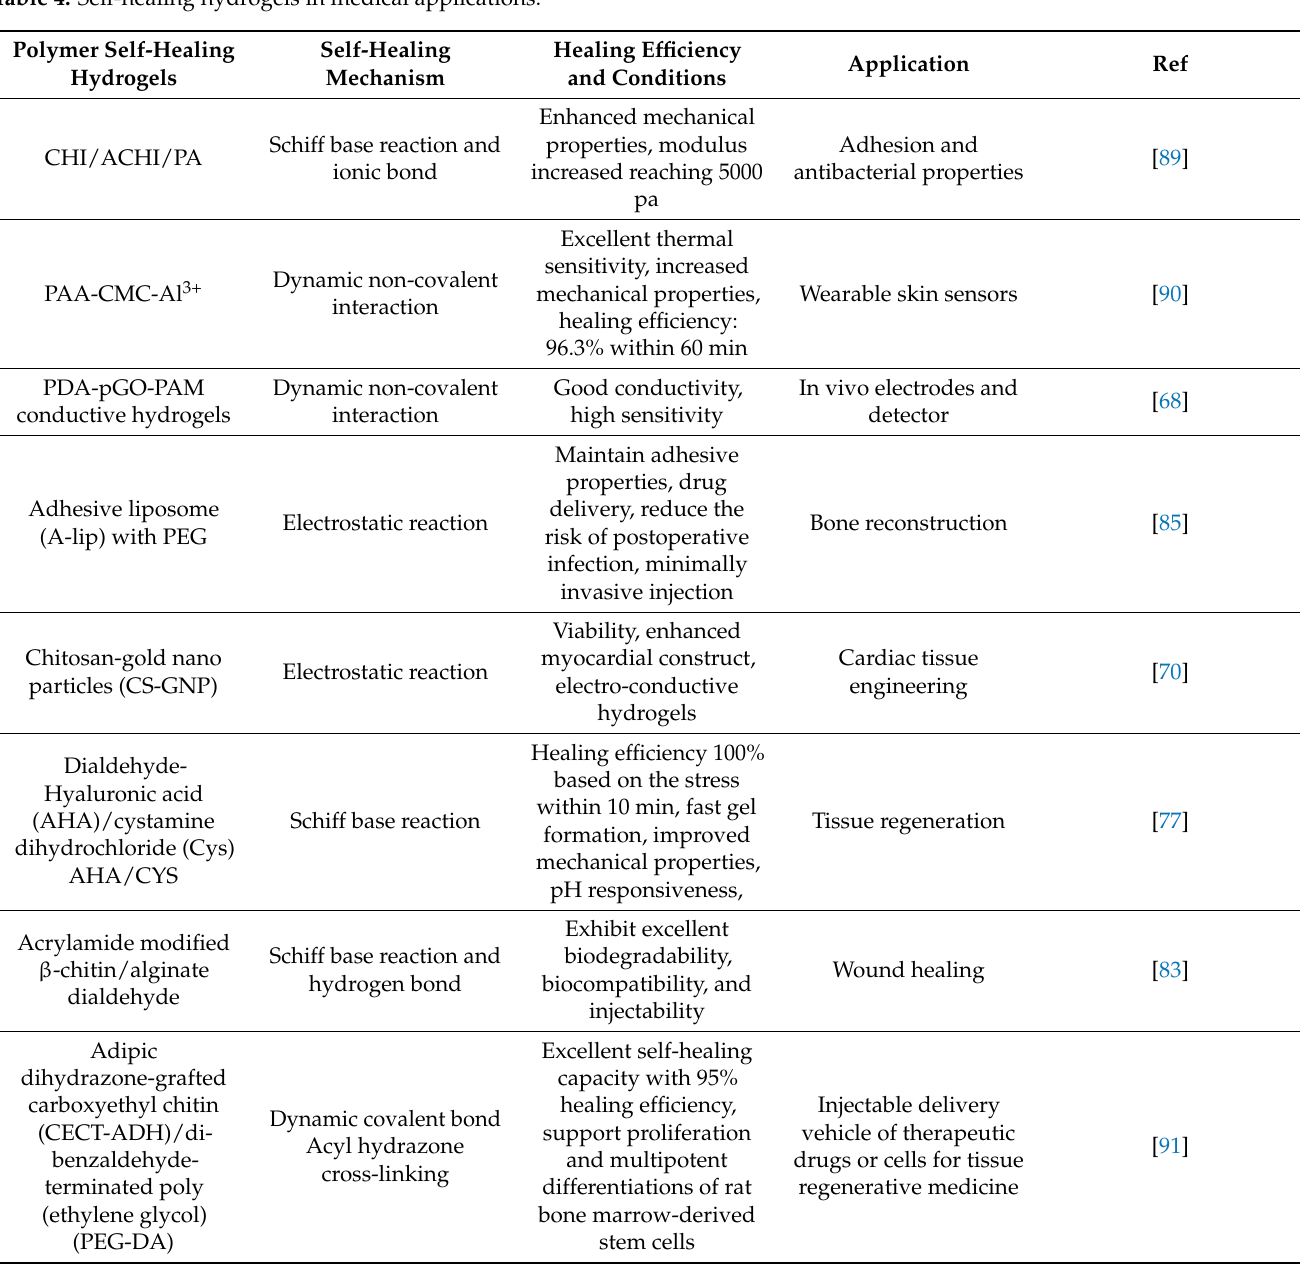
Table 4. Self-healing hydrogels in medical applications. Polymer Self-Healing